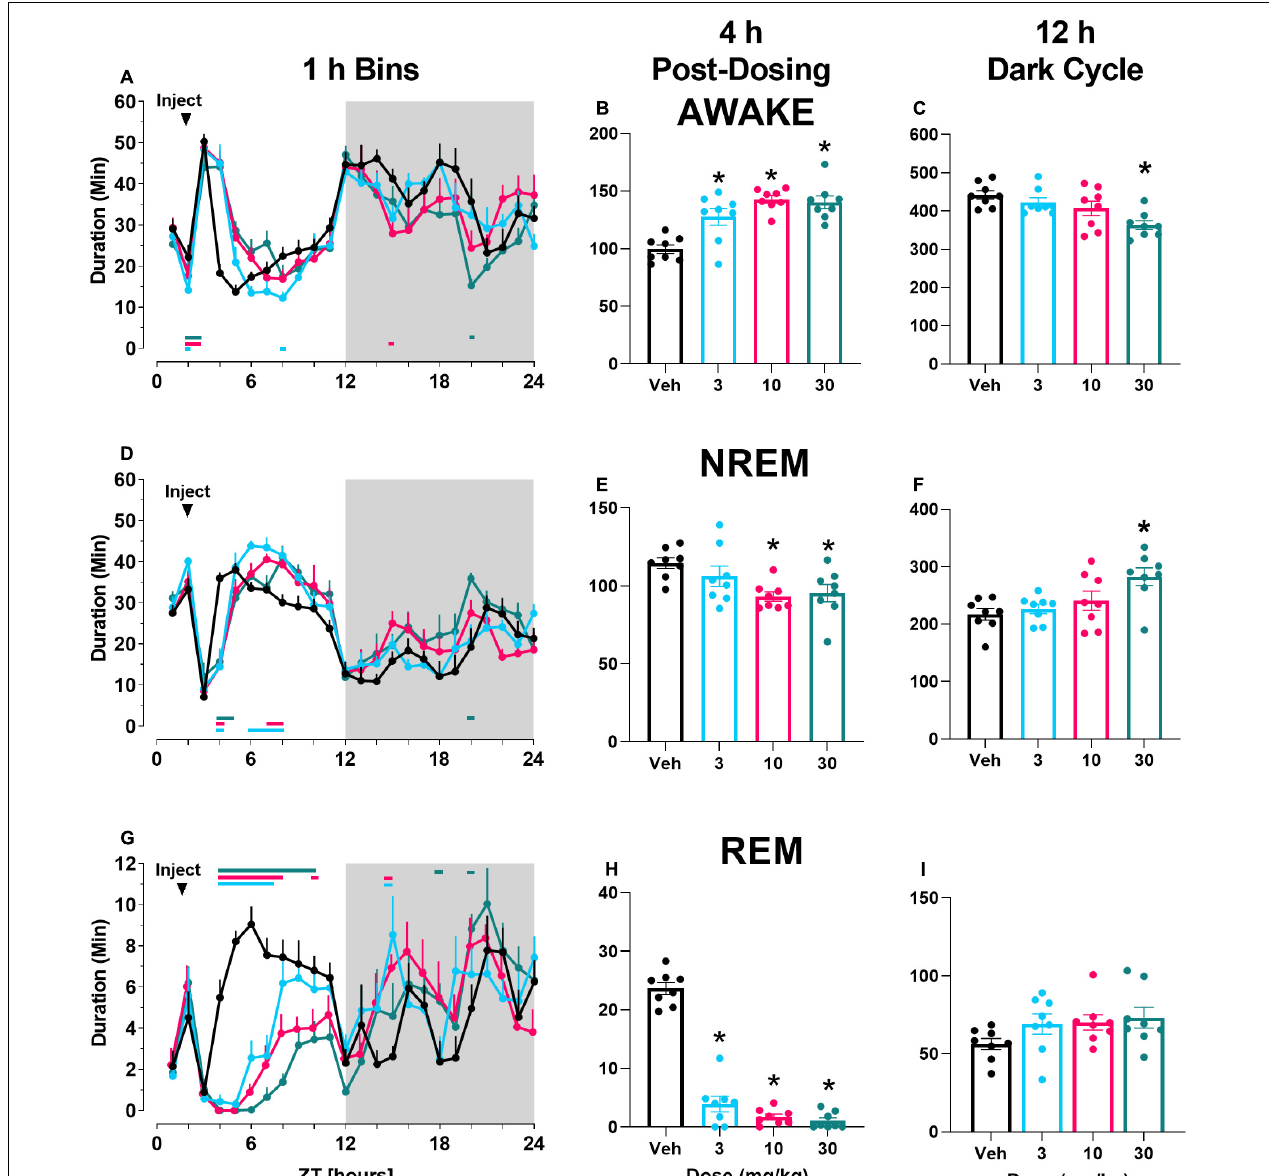
FIGURE 2 | VU0424238 increased time awake and decreased sleep time. Time spent in wake (A–C) , NREM (D–F) , and REM (G–I) sleep in 1 h bins (A,D,G) over a 24 h time period, summed duration over the first 4 h after VU0424238 administration (B,E,H) or the 12 h duration summed over the 12 h dark period (C,F,I) . VU0424238 was administered 2 h into the light period, noted by arrow. Corresponding horizontal colored lines (A,D,G) represent time points at which VU0424238 doses were statistically different from respective time in the vehicle-treated condition ( p < 0.05); * p < 0.05 compared to vehicle-treated condition. Line and bar graphs represent mean ± SEM ( n = 8); individual circles on bar graphs depict individual data points. Gray rectangle around ZT 12–24 represents dark